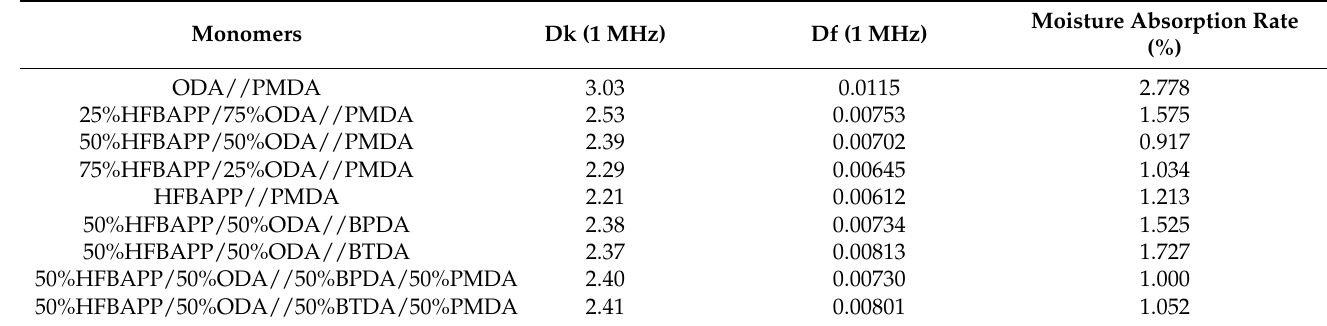
Table 6. Dielectric properties and hygroscopic of PI films in group HFOP and group HFOB.